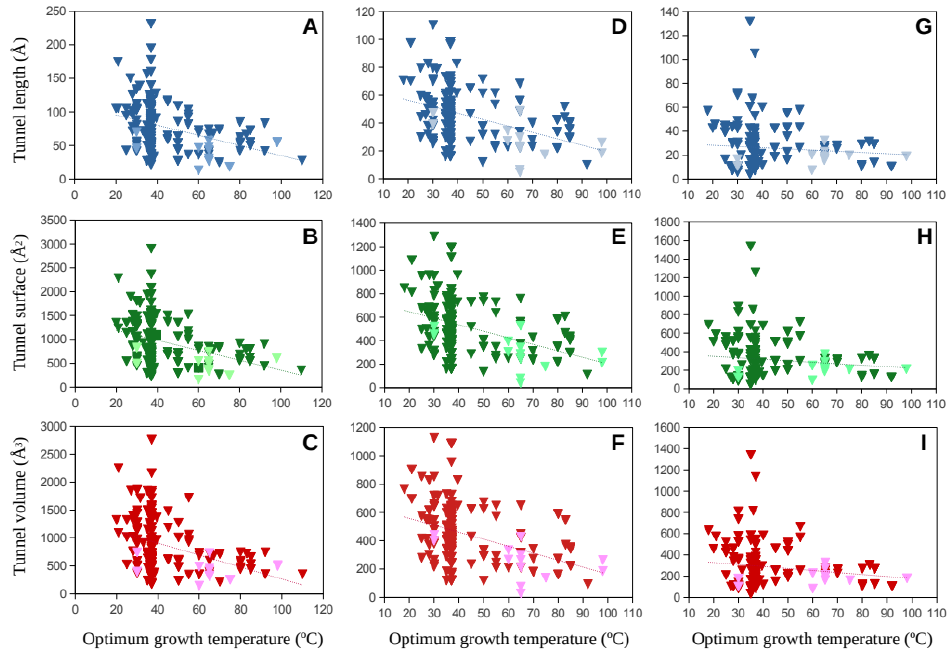
Figure 2. Molecular tunnel dimensions, length ( A , D , G ), surface ( B , E , H ), and volume ( C , F , I ) (in Å), predicted for the methyl-coenzyme M reductase (Mmr) subunit genes, alpha ( A , B , C ), beta ( D , E , F ), and gamma ( G , H , I ), from numerous methanogenic Archaea as a function of their optimum growth rates. Dark color-filled symbols correspond to predicted protein structures. Light color-filled symbols correspond to resolved model structures from the Protein Data Bank. Trend lines are presented as dotted lines.